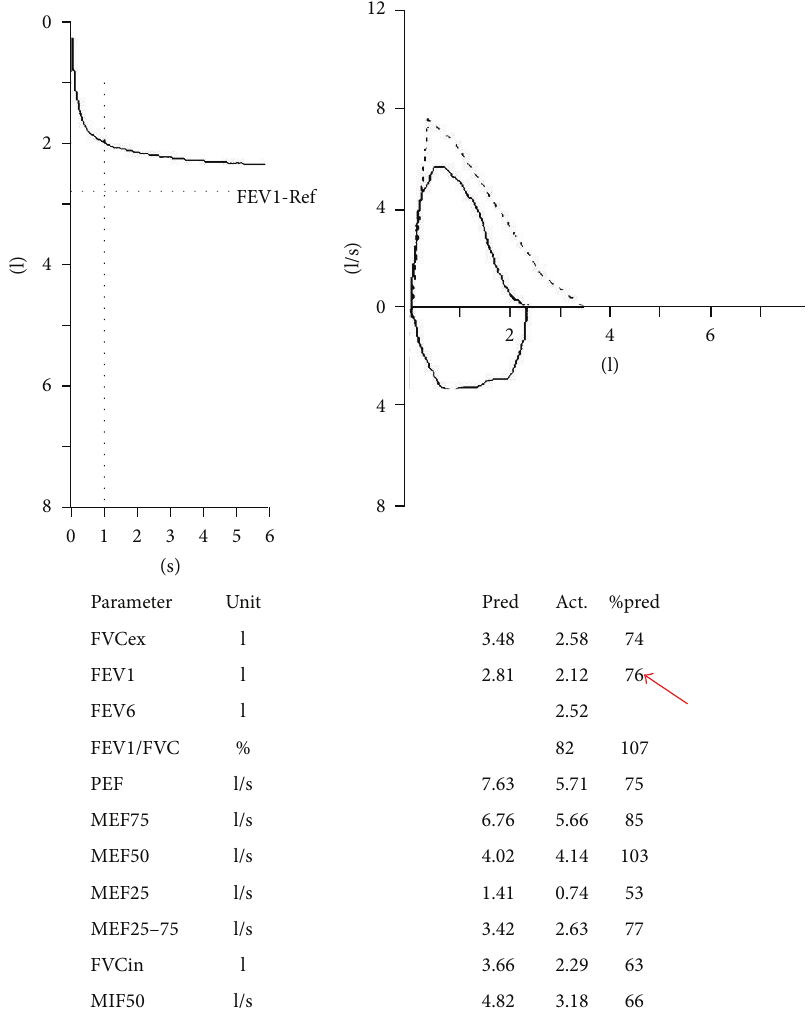
Figure 3: Repeated pulmonary function test after resection of the polyp resulted in improvement showing FEV1—76%.